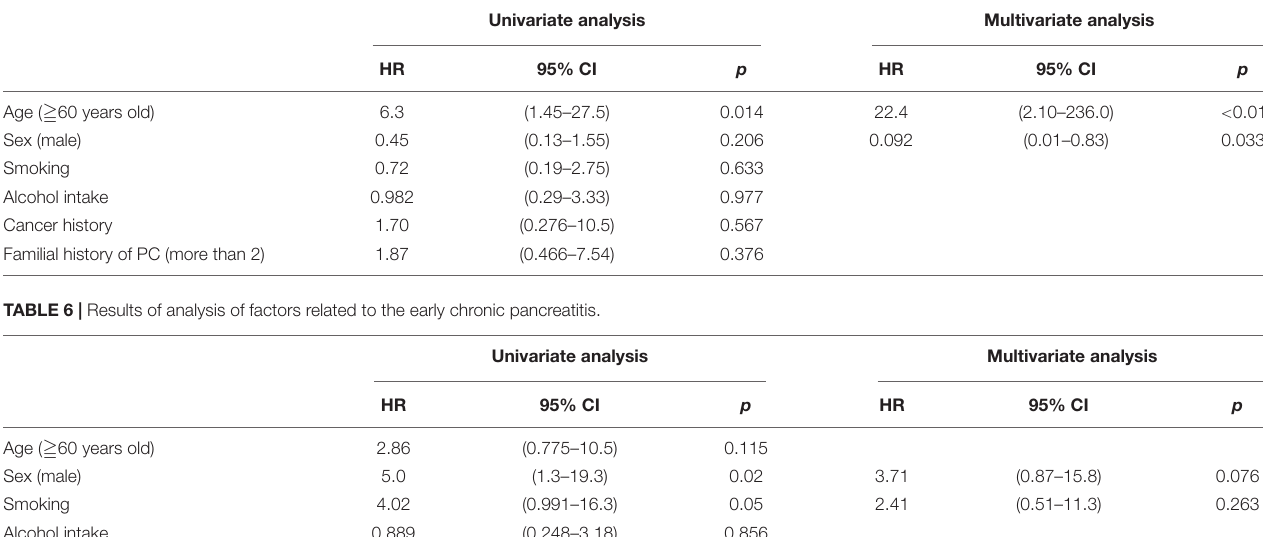
TABLE 5 | Results of analysis of factors related to a pancreatic cyst.